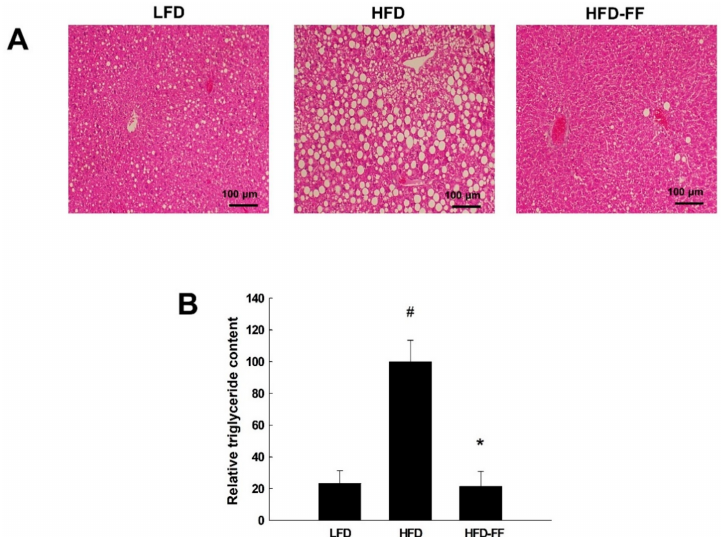
Figure 3. Effects of fenofibrate on hepatic lipid accumulation in HFD-fed female OVX mice. OVX C57BL/6J mice were fed an LFD, an HFD or an HFD supplemented with fenofibrate (HFD-FF, 0.05% w/w ) for 21 weeks. ( A ) Hematoxylin-eosin-stained sections of liver tissues (original magnification × 100). ( B ) Relative triglyceride content. All values are expressed as the mean ± SD ( n = 8/group). # p < 0.05 compared with LFD. * p < 0.05 compared with